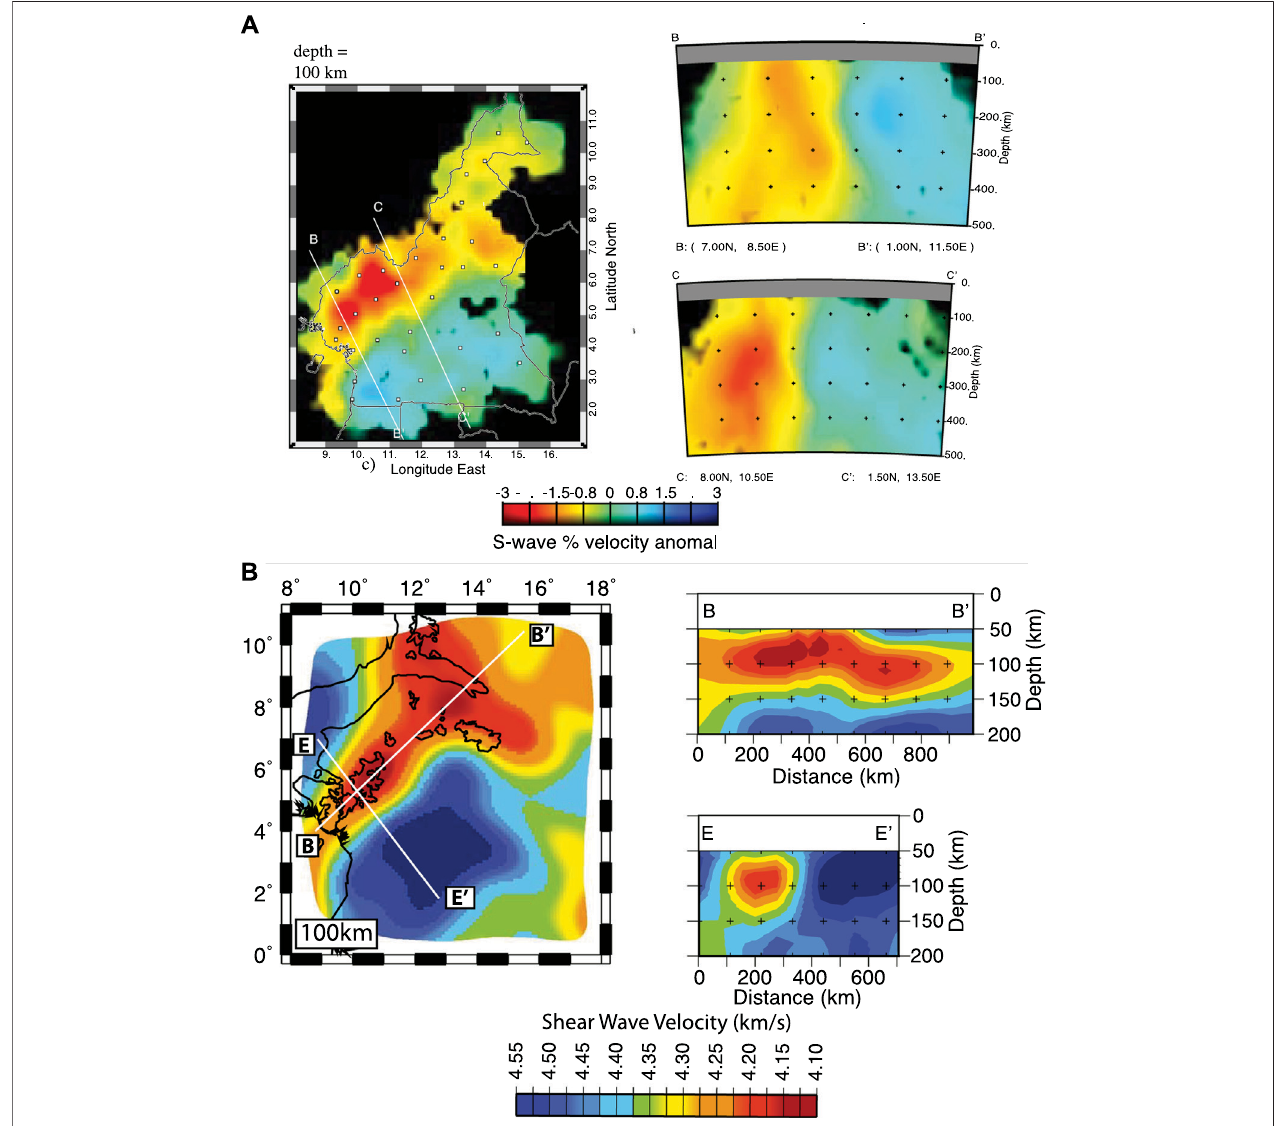
FIGURE6| Tomographicmodels. (A) A100 kmdepthsliceandselectedcross-sectionsfromanS-wavebodywavetomographymodel(adaptedwithpermission from Reusch et al., 2010). (B) A 100 km depth slice and selected cross-sections from an S-wave model derived from Rayleigh wave tomography (adapted with permission from Adams et al.,